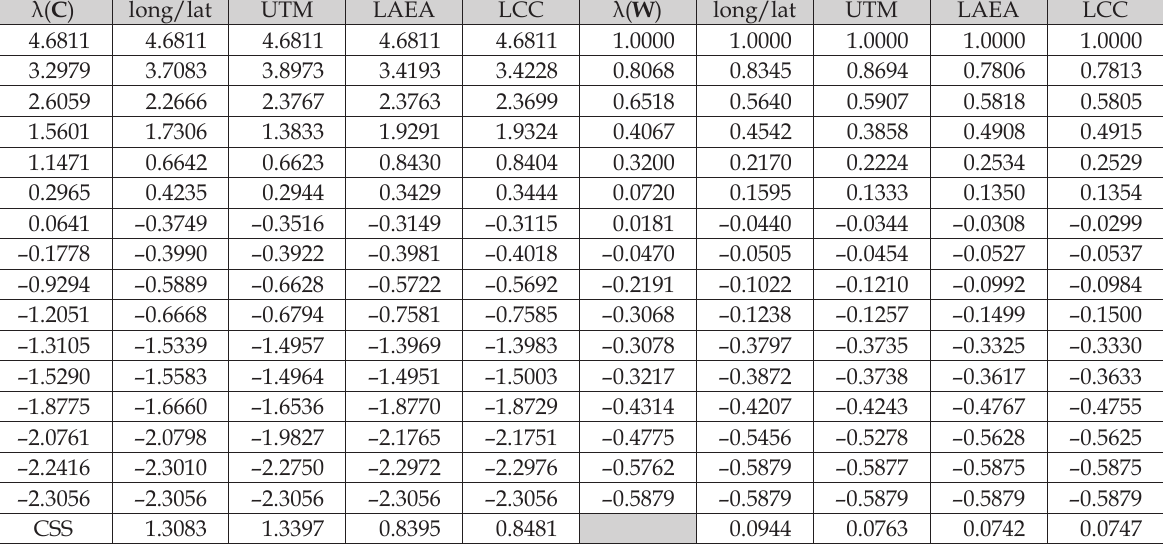
Table B1. Matrix C eigenvalue approximations for selected map projection